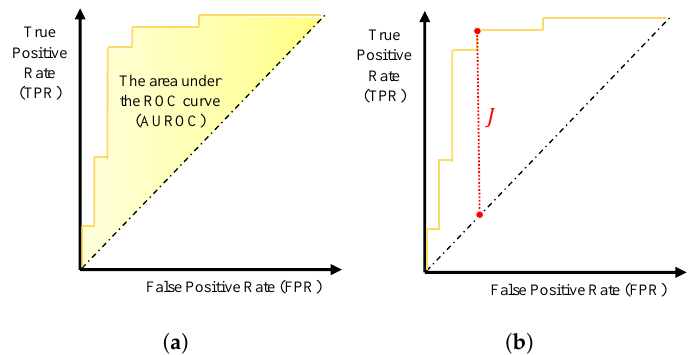
Figure 10. Two types of performance indices. ( a ) AUROC; ( b ) Youden index ( J ) by